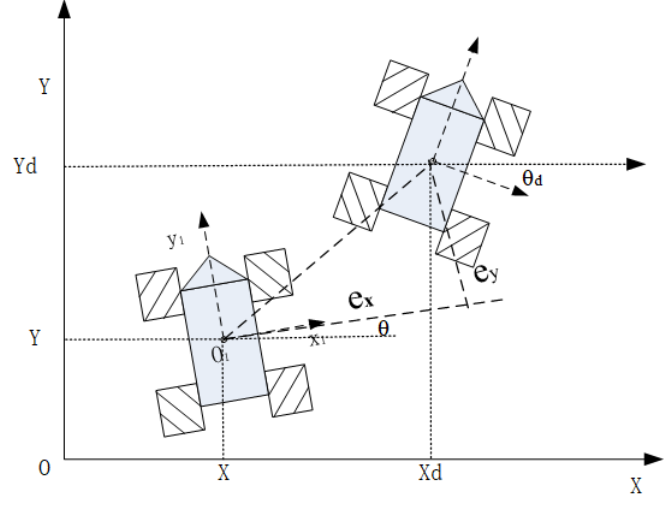
Figure 4. Tracking